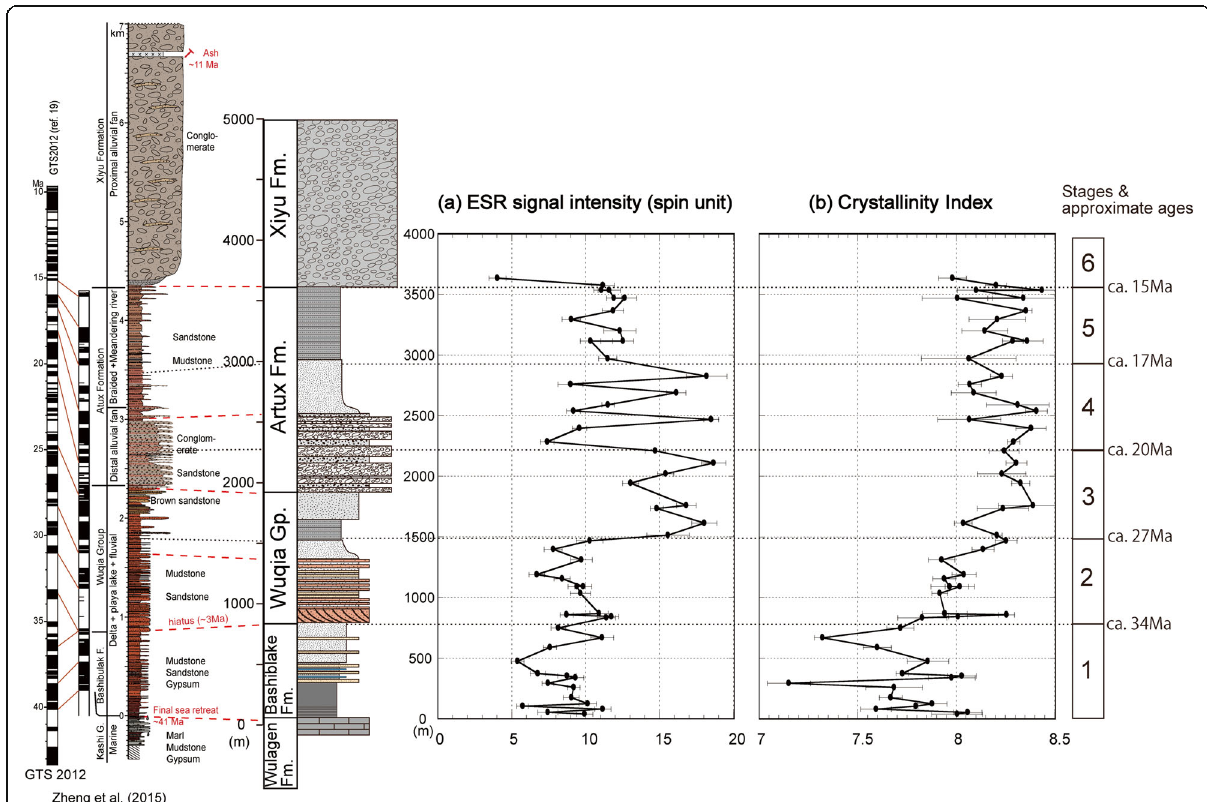
Fig. 4 Temporal changes in a the ESR signal intensity and b CI of the Aertashi section. Red lines between columnar section of ours and Zheng et al. (2015) indicate the correlated layers and black lines indicates stage boundaries in this